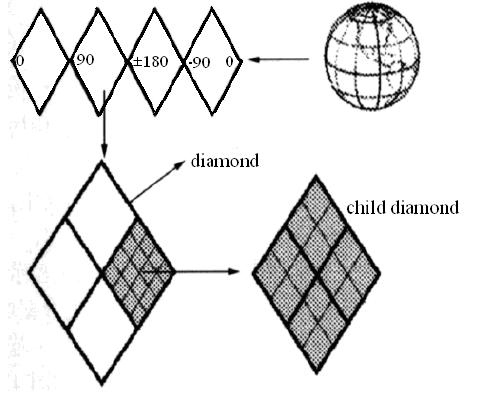
Figure 2. The global diamond grid[Zhao et al.